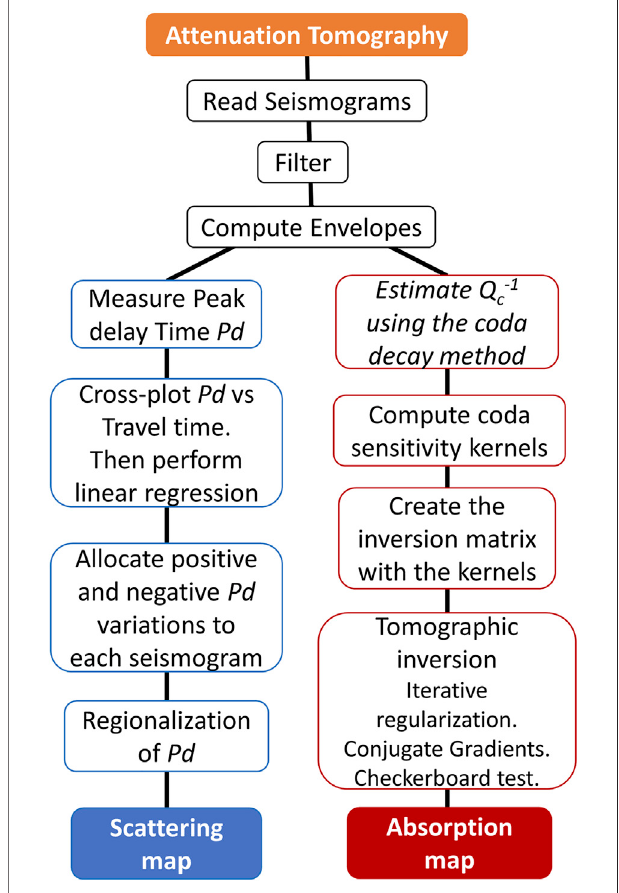
FIGURE5| Work fl owoftheattenuationtomographymethodsappliedto map peakdelay(leftside) andcodaattenuation (rightside)forimagingseismic scattering and absorption,